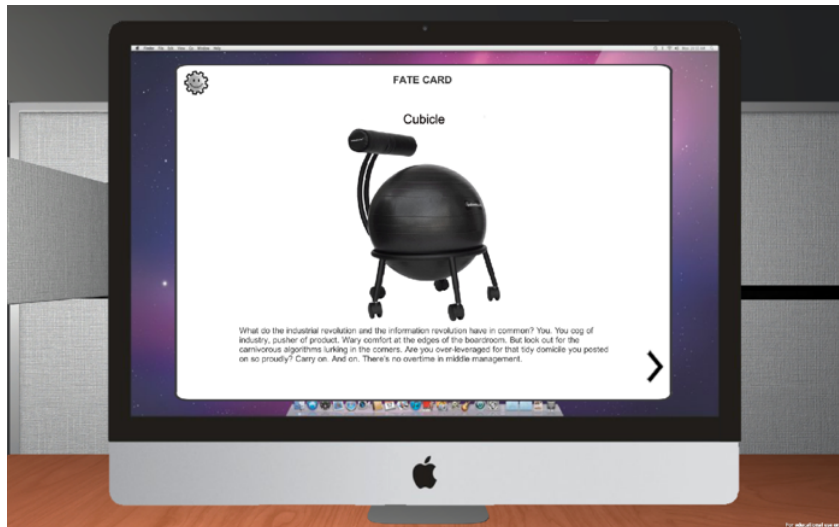
Figure 13. Still from Psychasthenia 3: Dupes . Courtesy of the